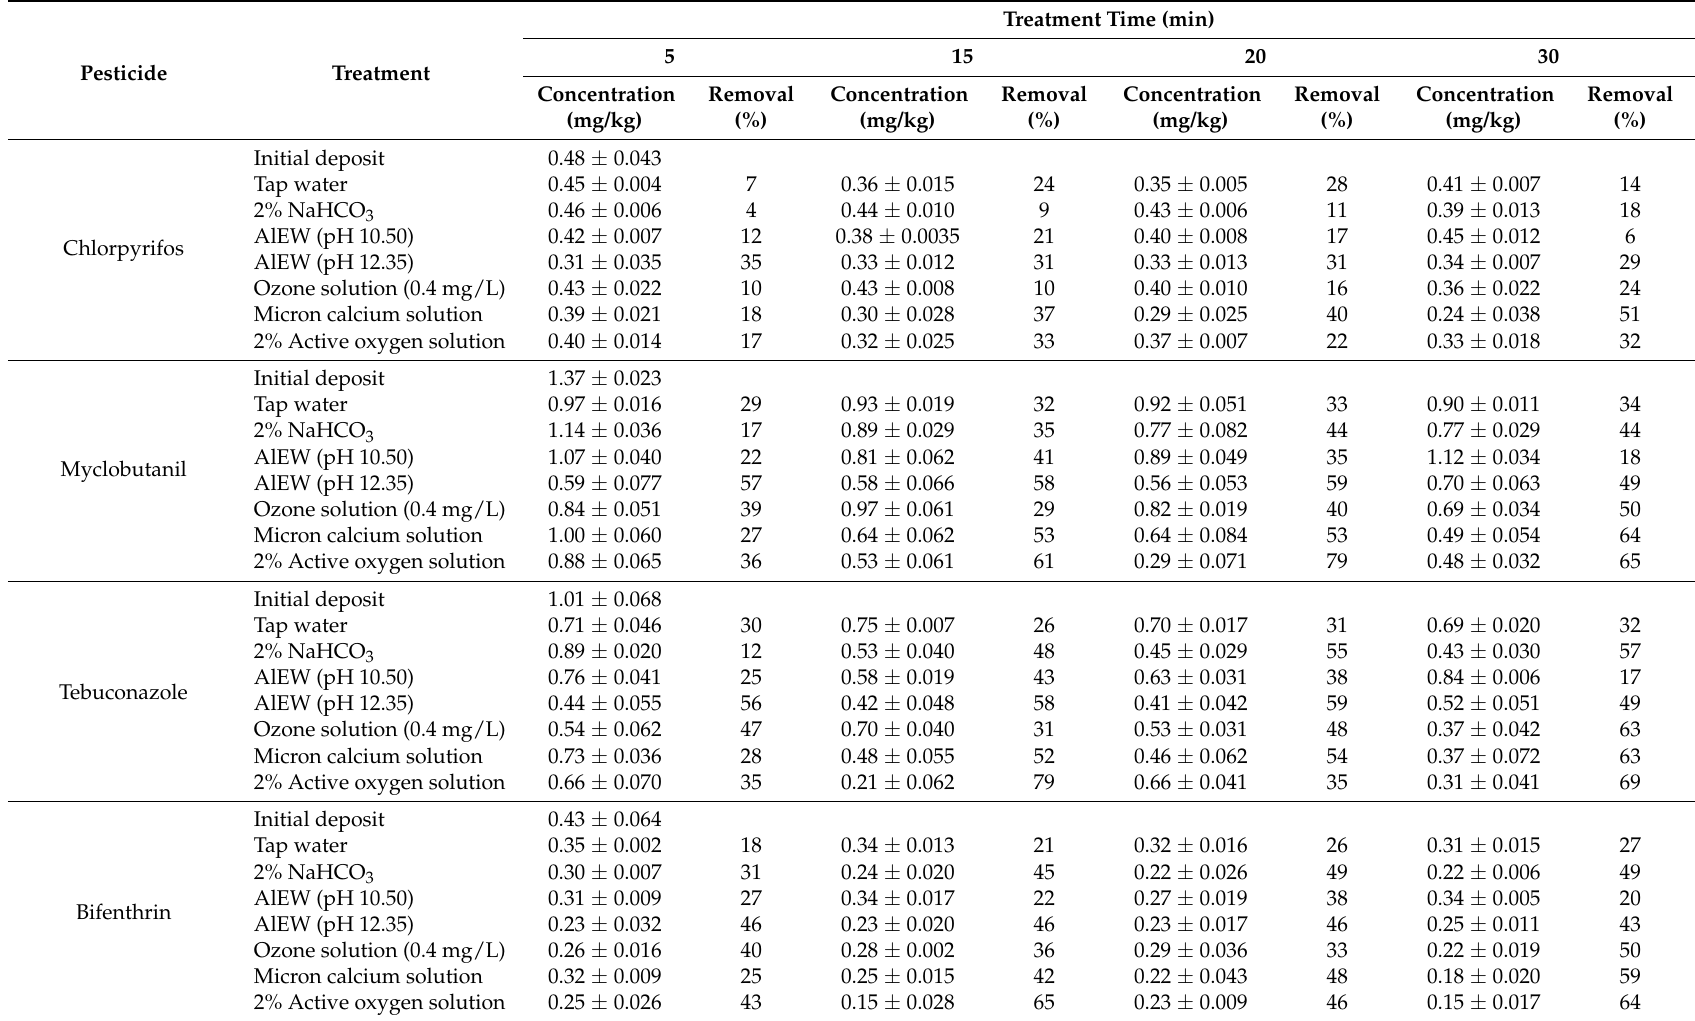
Table 6. Effect of washing treatments for pesticide removal in kumquat ( n =